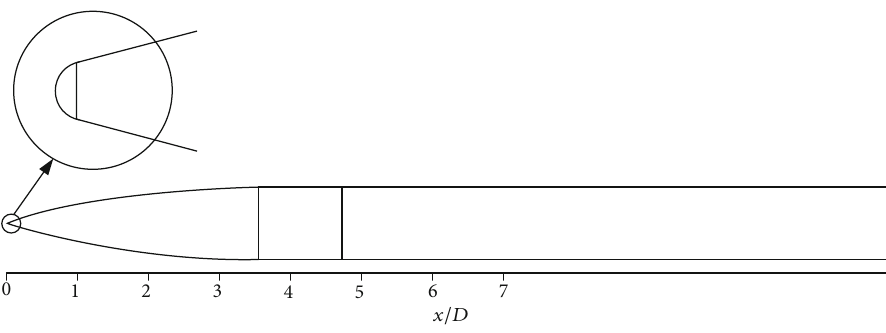
Figure 1: Schematic of experimental model and partially enlarged drawing of head.